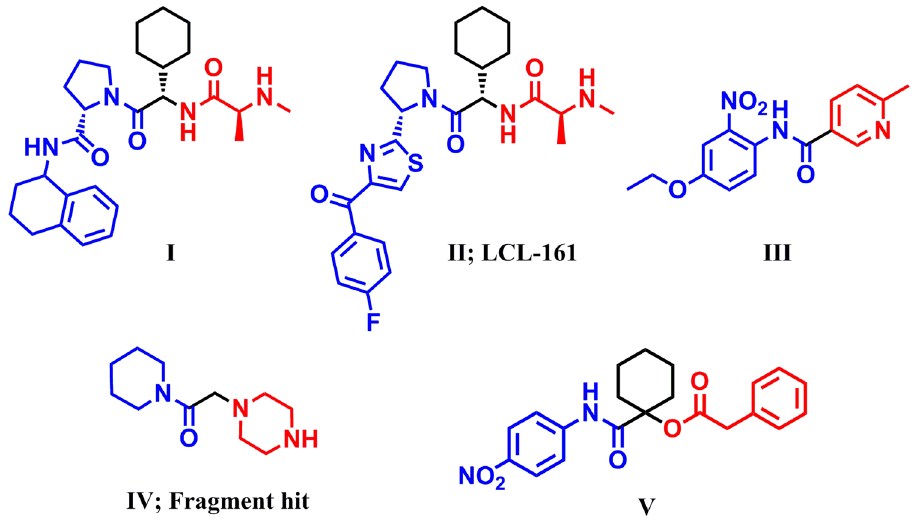
Figure 1. Lead Small-molecules caspase